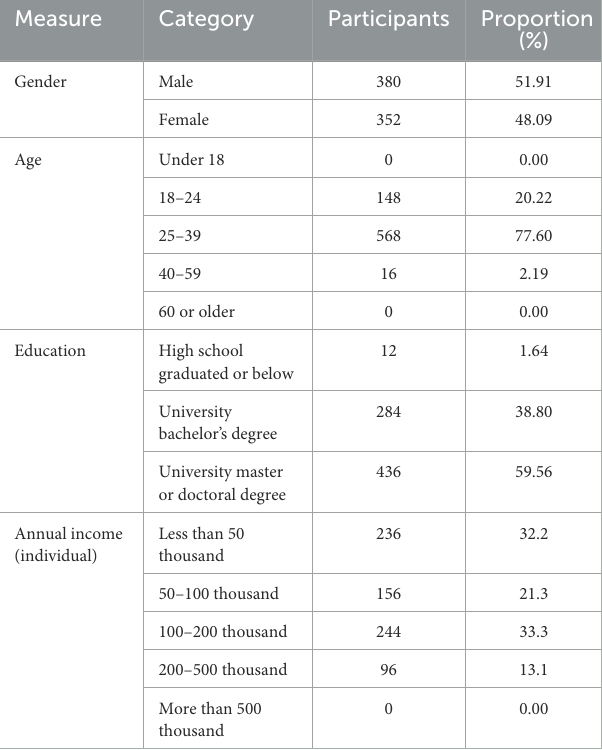
TABLE 1 Demographic information of the survey sample group ( N =